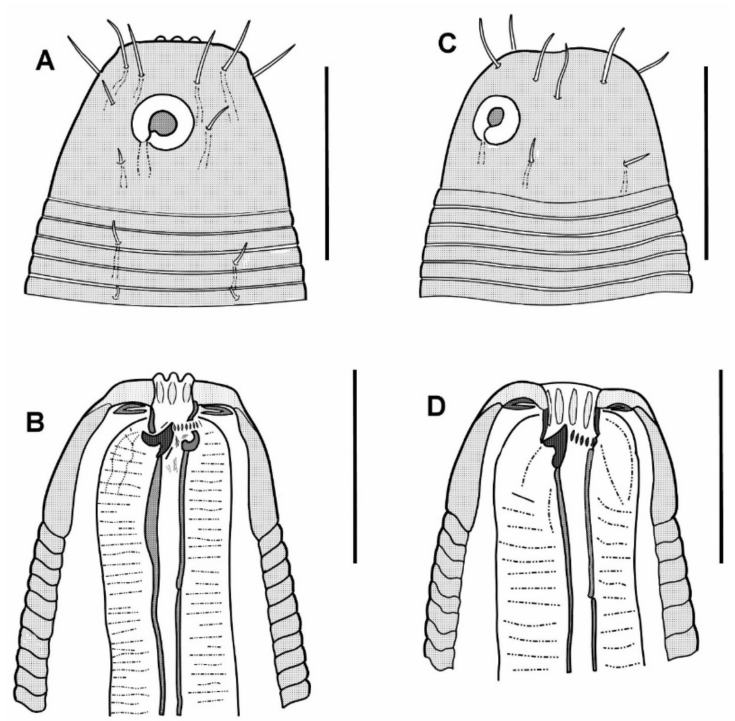
Figure 12. Acanthopharynx parva sp. n., anterior ends: ( A) holotype male, surface view; ( B) holotype male, optical section; ( C )—allotype female, surface view; ( D ) allotype female, optical section. Scale bars 20 µ m.